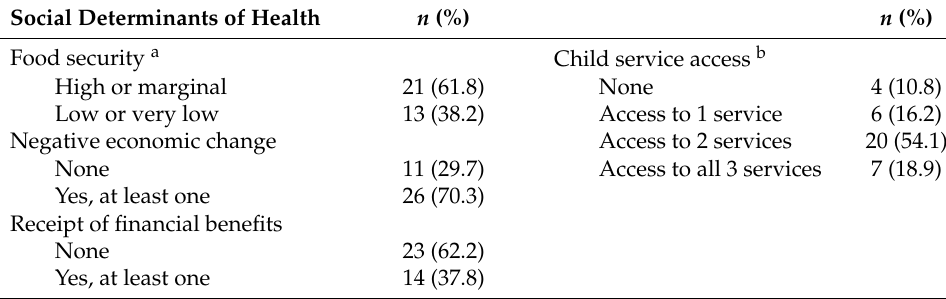
Table 2. Social determinants of health during the COVID-19 pandemic.